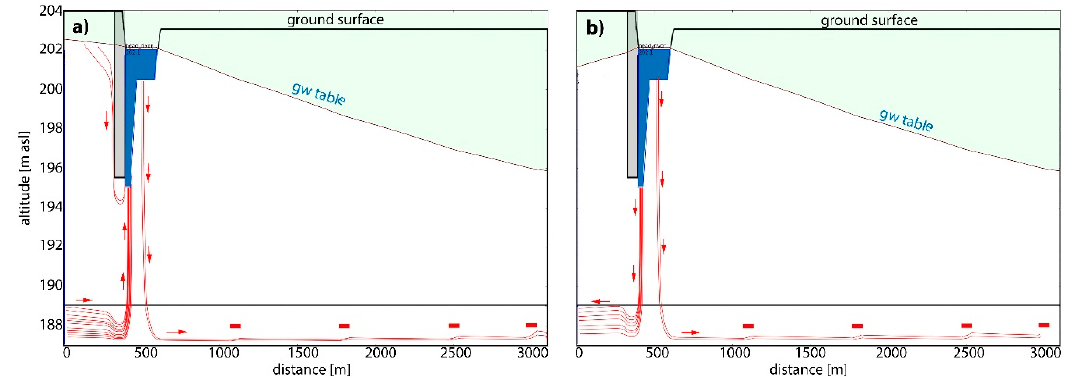
Figure 3. ( a ) Model 1: Gaining stream conditions prevail in the west. Red lines: particle tracking (forward), red arrows: groundwater flow direction, red bars: well screens, grey areas: silt-clay zones. Note the different scales (in m) on the x- and z-axes. ( b ) Model 2: Losing stream conditions prevail in the western part of the model. Table 1. Parameters used to set up the initial 2D flow models (models 1 and 2).